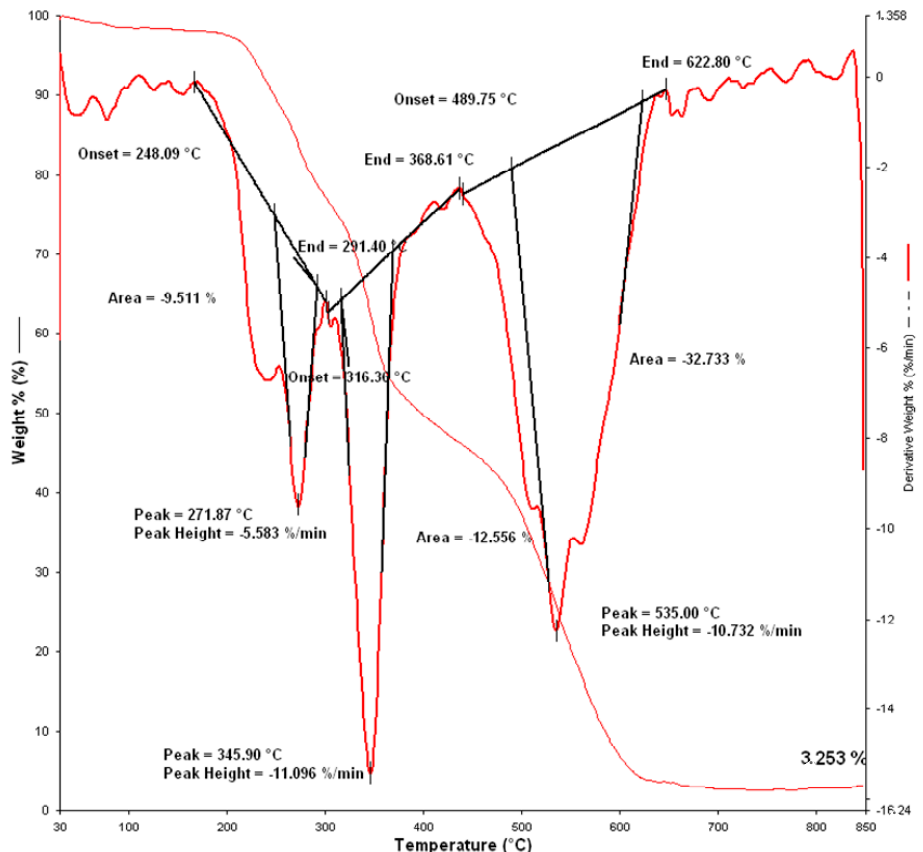
Figure 13. Thermal gravimetric analysis of the material sample of the overalls after exposure to an explosive fire on a fire manikin (Sample 2): TG curve, dTG curve.